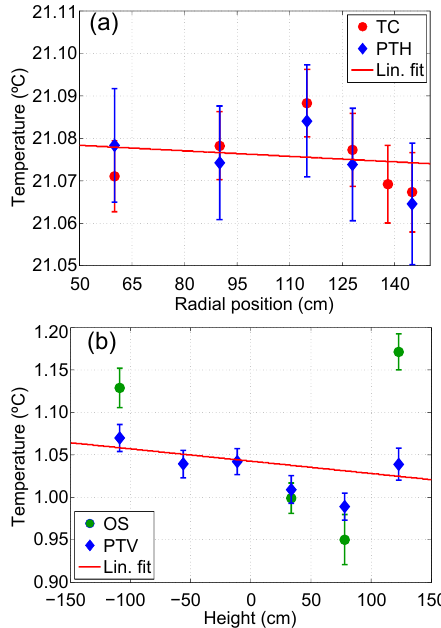
Figure 6. Maximum temperature difference from the string mean (temperature non-uniformity), (cid:49)T , in the (a) horizontal and (b) ver- tical directions at chamber temperatures between − 70 and 20 ◦ C. The data were recorded during both calibration (solid symbols) and data-collecting runs (hollow symbols) in June and September– October 2014, respectively.